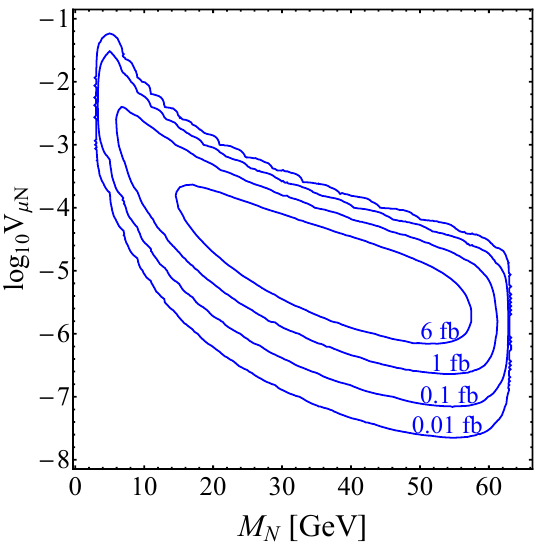
Figure 3 . Displaced vertex event rate at the LHC N events decaying at a distance between 1 cm and 1 m, as a function of the neutrino mass and M N and